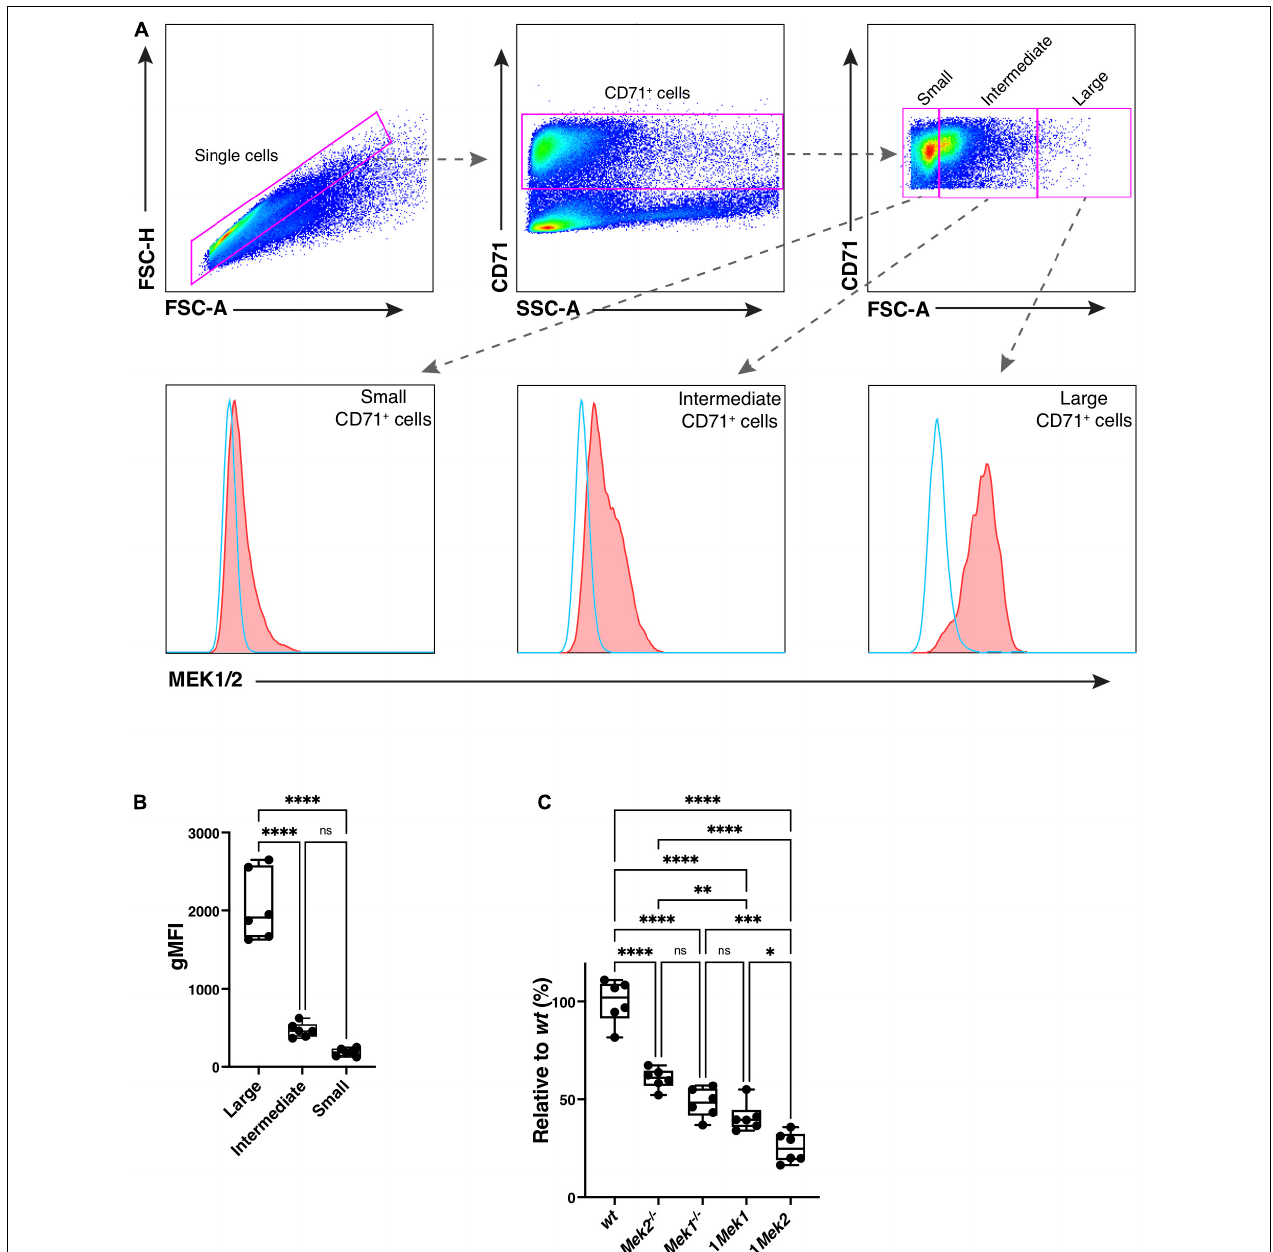
FIGURE 9 | Loss of MEK Protein Expression During the Erythropoietic Cell Differentiation. (A) Representative dot plots show the flow cytometry gating strategy used to quantitate the levels of MEK1 and MEK2 proteins in CD71 + erythroid precursors isolated from bone marrow of wt and Mek mutants. MEK protein levels in wt specimens were measured in CD71 + cells of different sizes using the forward scatter. The larger cells correspond to the ProE and Ery.A cells, whereas the cells with the intermediate and small sizes correspond to more differentiated Ery.B cells. (B) The geometric mean of the fluorescence intensity (gMFI) for intracellular staining of MEK1/2 was used to quantify the levels of MEK protein. High levels of MEK protein were detected in ProE and Ery.A precursors (no antibody in blue and with anti-MEK1/2 in red). (C) Quantification of MEK protein levels in the allelic series of Mek mutants relative to the levels in wt was performed for the large CD71 + cells. * P < 0.05, ** P < 0.01, *** P < 0.001, **** P <